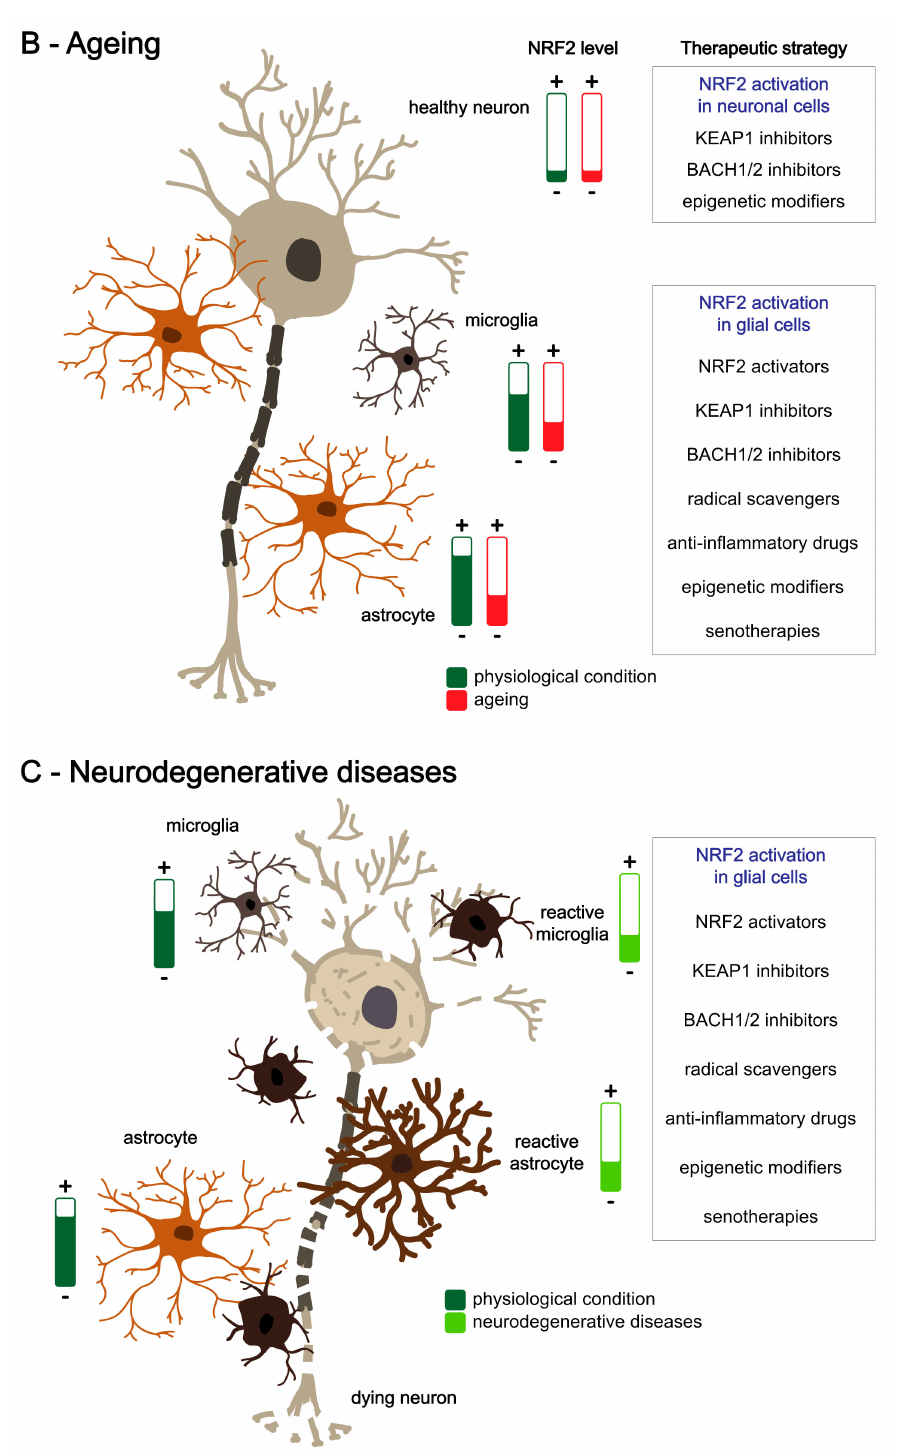
Figure 4. NRF2-signalling-based therapeutic strategies in brain dysfunctions. Targeting NRF2 pathway in brain diseases appears as a promising therapeutic strategy. Different options exist depending on the context (cancer ( A ), ageing ( B ), and neurodegenerative diseases ( C )), NRF2 lev- els, and the cells to target (neuronal or glial cells). NRF2 and NRF2-negative regulators (KEAP1, BACH1, BACH2) can be targeted in these different conditions. The emergence of senotherapeutic drugs (senolytics, senomorphics) coupled to epigenetic modifiers (inhibitors/activators of histone acetyltransferases, histone deacetylases, histone demethylases, and histone methyltransferases) could provide a great number of translational opportunities and thus contribute to improving human